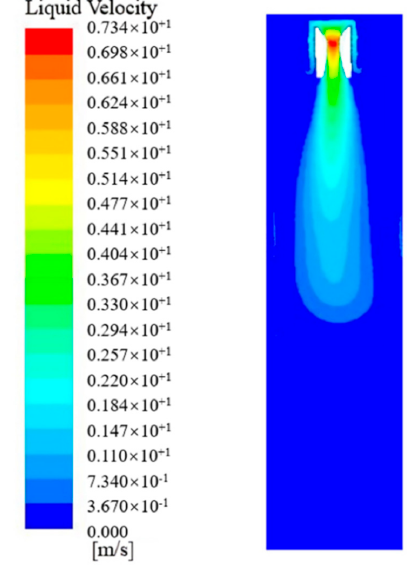
Figure 5. Velocity contour of Venturi distributor at central surface.